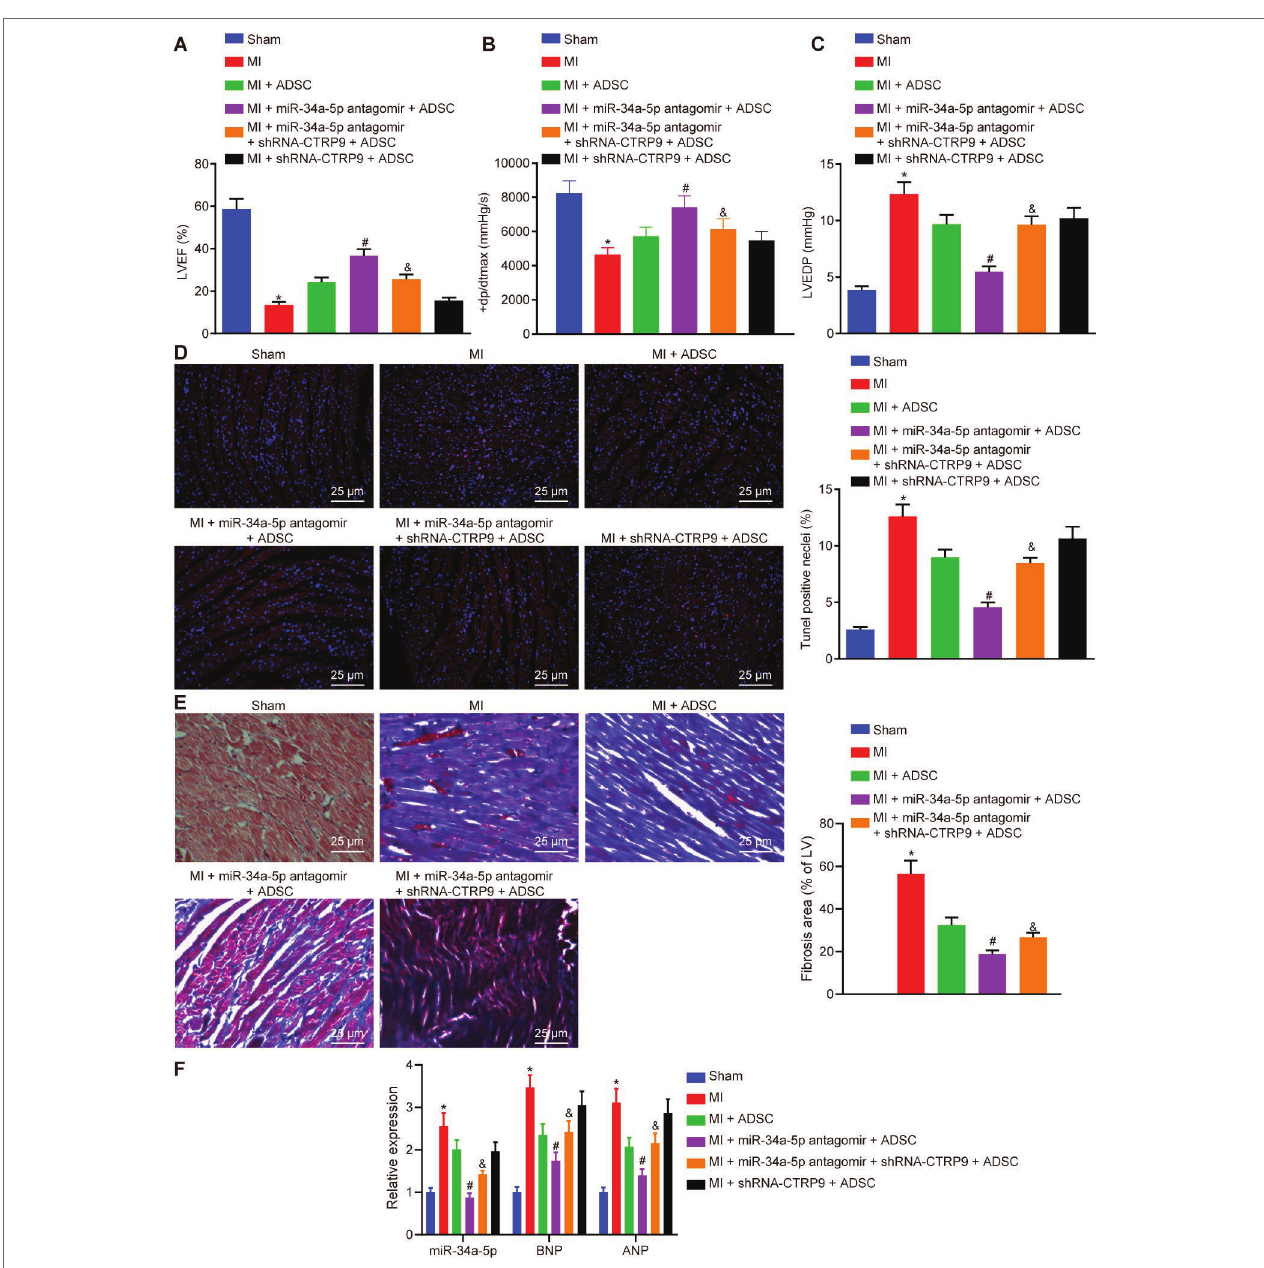
FIGURE 6 | Down-regulated miR-34a-5p promotes the protective role of ADSCs against MI damage in vivo by up-regulating CTRP9 expression. (A) LVEF of mice in each group. (B) +dp/dtmax of mice in each group. (C) LVEDP of mice in each group. (D) Myocardial cell apoptosis in mice of each group detected by TUNEL staining (400 ×). (E) Masson’ s trichrome staining of myocardial tissues in mice of each group (400 ×). (F) Expression of miR-34a, BNP, and ANP in myocardial tissues detected using RT-qPCR. * p < 0.05 vs. the sham group; # p < 0.05 vs. the MI + ADSC group; & p < 0.05 vs. the MI + miR-34a-5p antagomir + ADSC group. Data (mean ± s.d.) among multiple groups were analyzed by one-way ANOVA, followed by Tukey’s post hoc test. The experiment was repeated three times. CTRP9, C1q/tumor necrosis factor-related protein-9; miR-34a-5p, microRNA-34a-5p; ADSC, adipose-derived stem cell; MI, myocardial infarction; LVEF, left ventricular ejection fraction; LVEDP, left ventricular end-diastolic pressure; TUNEL, terminal deoxynucleotidyl transferase-mediated dUTP-biotin nick end labeling; s.d., standard deviation; ANOVA, analysis of